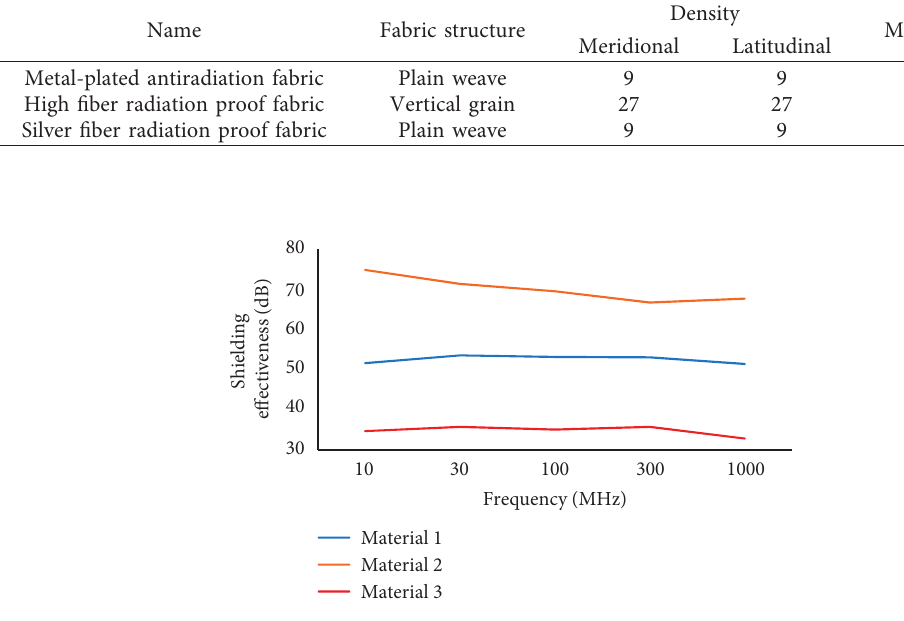
Figure 11: Shielding effectiveness test results of different